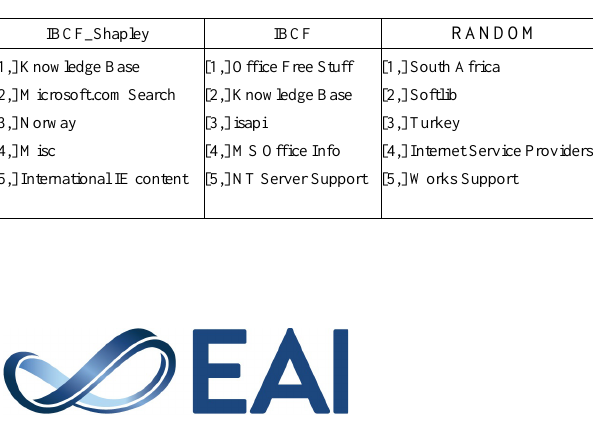
Table 6. Five comics in MSWeb are consulted on three models